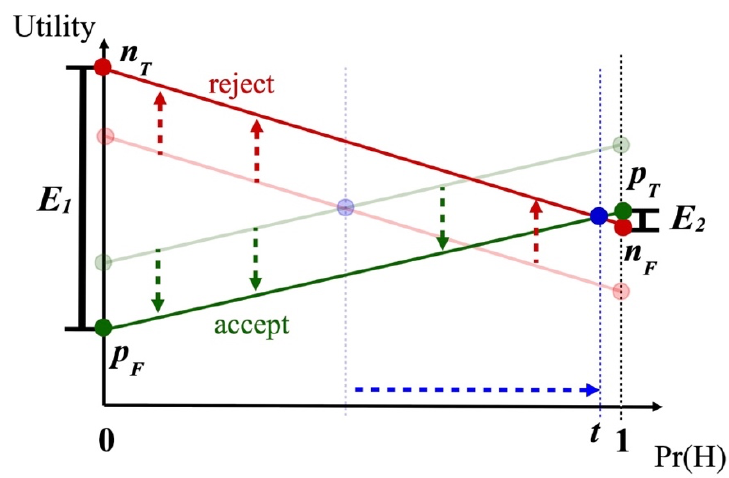
Figure 3. How inconvenience may affect evidential standards via misuse of the AIR: costs of accepting H (or benefits of rejecting H), irrespective of its truth or falsity, lower the “accept” line (or raise the “reject” line). This makes it rational to raise the evidential bar for H (reflected here in t approaching Pr(H) = 1), but for the wrong sort of reason. Inconvenience adds real costs to potential errors, but costs tied to error only